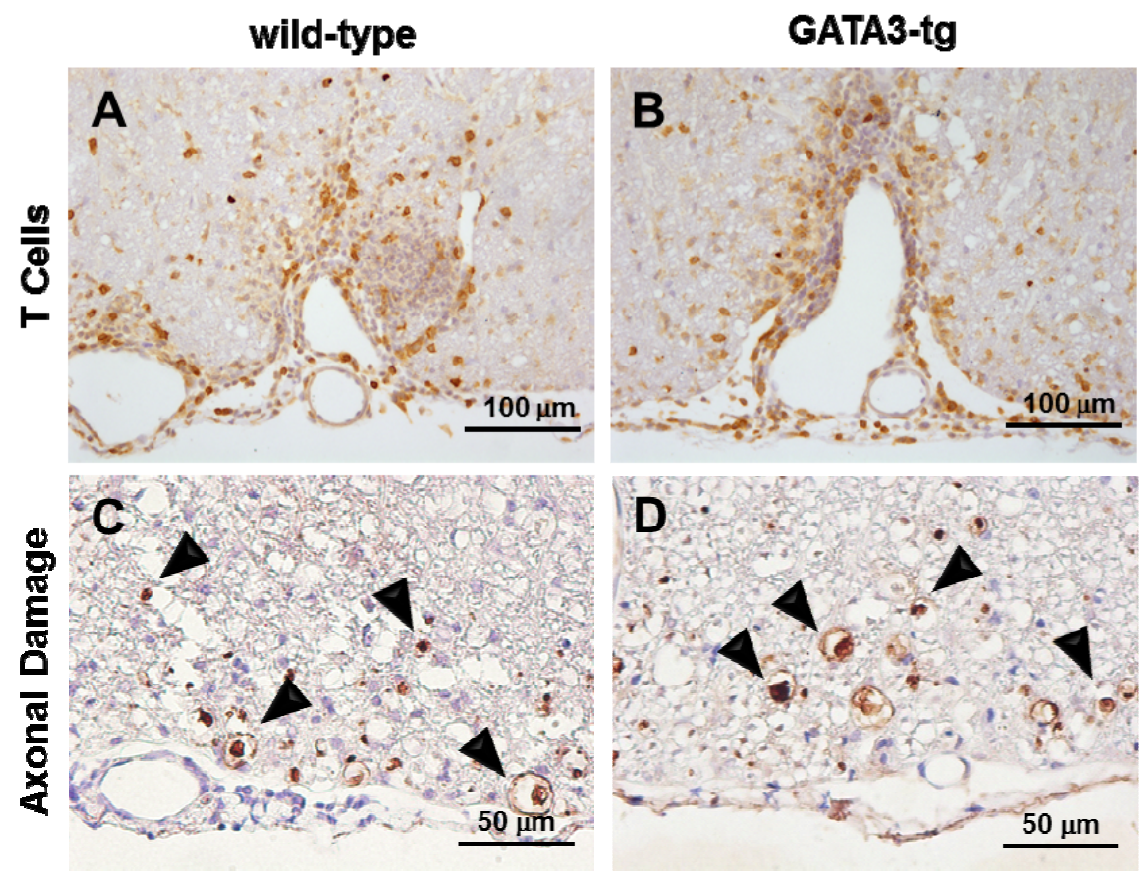
Figure 4. Similar percentages of CD3 + T cells among MNC infiltrates were observed in the spinal cord lesions of wild-type ( A ) and GATA3-tg mice ( B ) by anti-CD3 immunohistochemistry, two weeks p.i. ( A , B ). Similar numbers of damaged axons (arrowheads) were observed in wild-type ( C ) and GATA3-tg mice ( D ) by anti-nonphosphorylated neurofilament staining, two months p.i. ( C , D ). Representative spinal cord sections from five independent experiments. Magnification: ( A , B ) ×171; ( C , D )